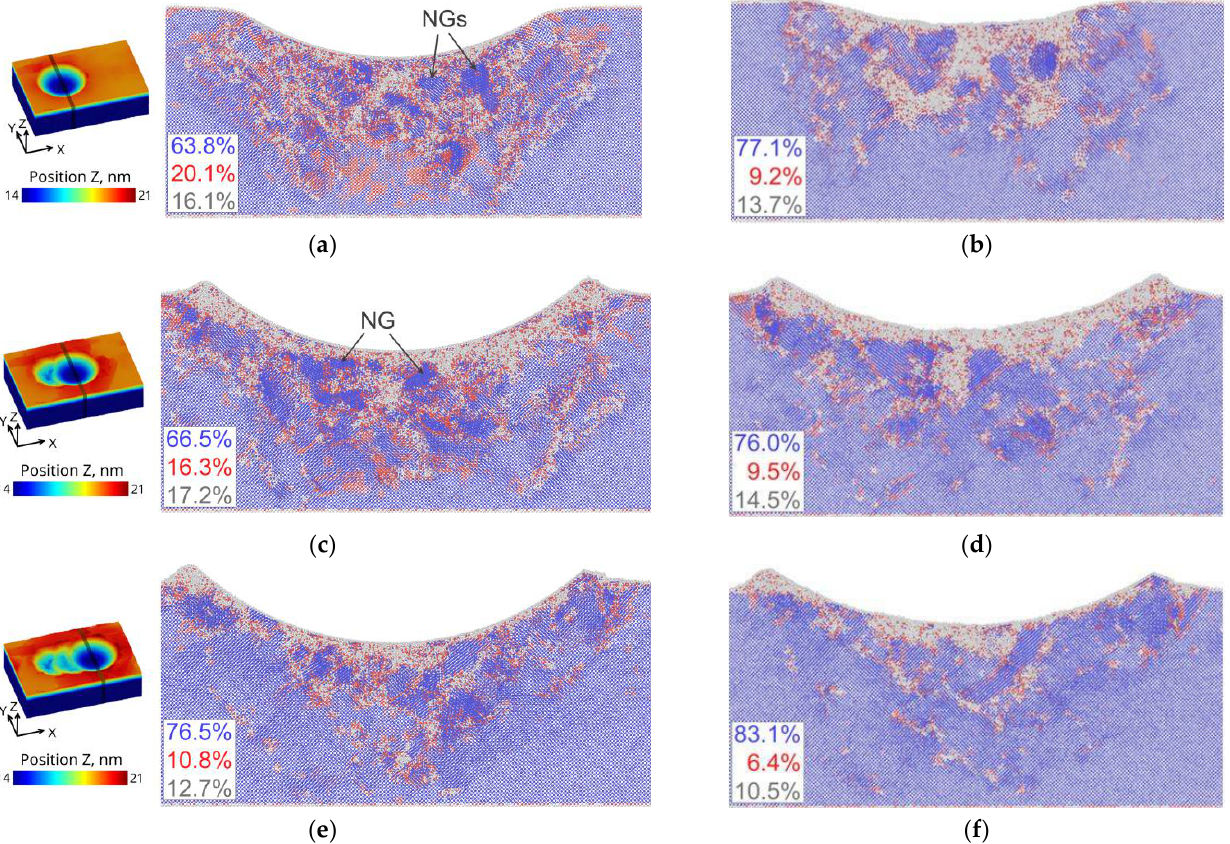
Figure 10. Cross-sectional snapshots (projection onto the YZ plane in the middle of the indentation imprint, exact positions are shown at the left panel) illustrating the microstructure of the bcc-Ti crystallite containing 20 at.% of vanadium under applying the maximum load ( a , c , e ) and after unloading ( b , d , f ) for the first ( a , b ), second ( c , d ) and third ( e , f ) indentations. The color of atoms corresponds to different local configurations of the atomic lattice according to CNA: bcc atoms are shown blue, hcp atoms are shown red, and atoms belonging to an unidentified lattice are shown grey. The volume fraction of the atoms is given in the lower right corner by blue, red and gray colors correspondingly.